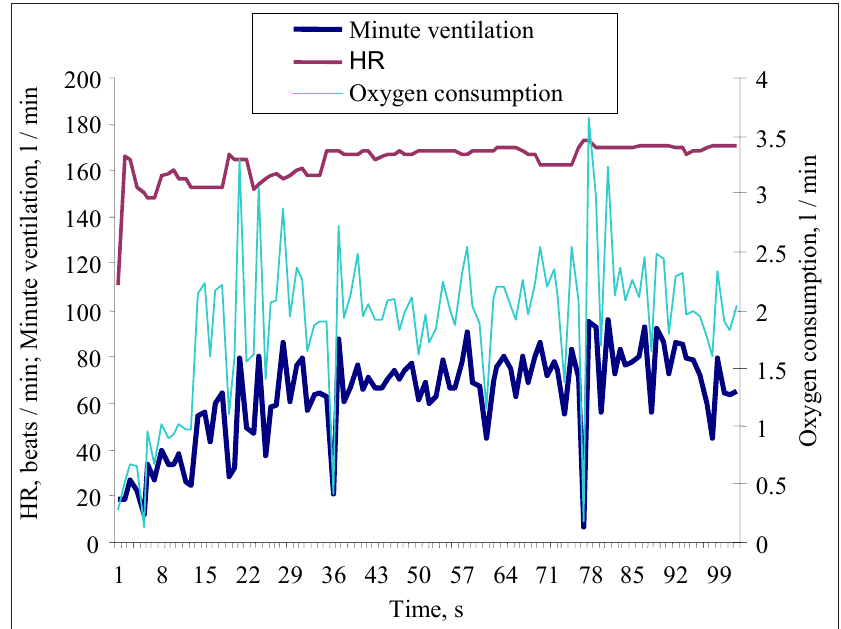
Fig. 2. Heart rate, minute ventilation and oxygen consumption